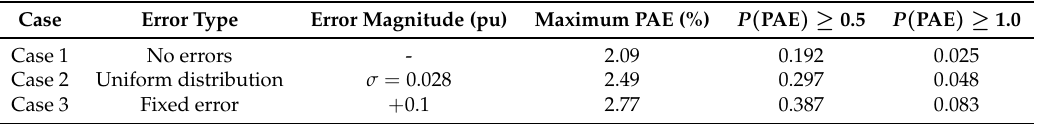
Table 4. Performance of DSSE with grid parameters for the year 2018 data.